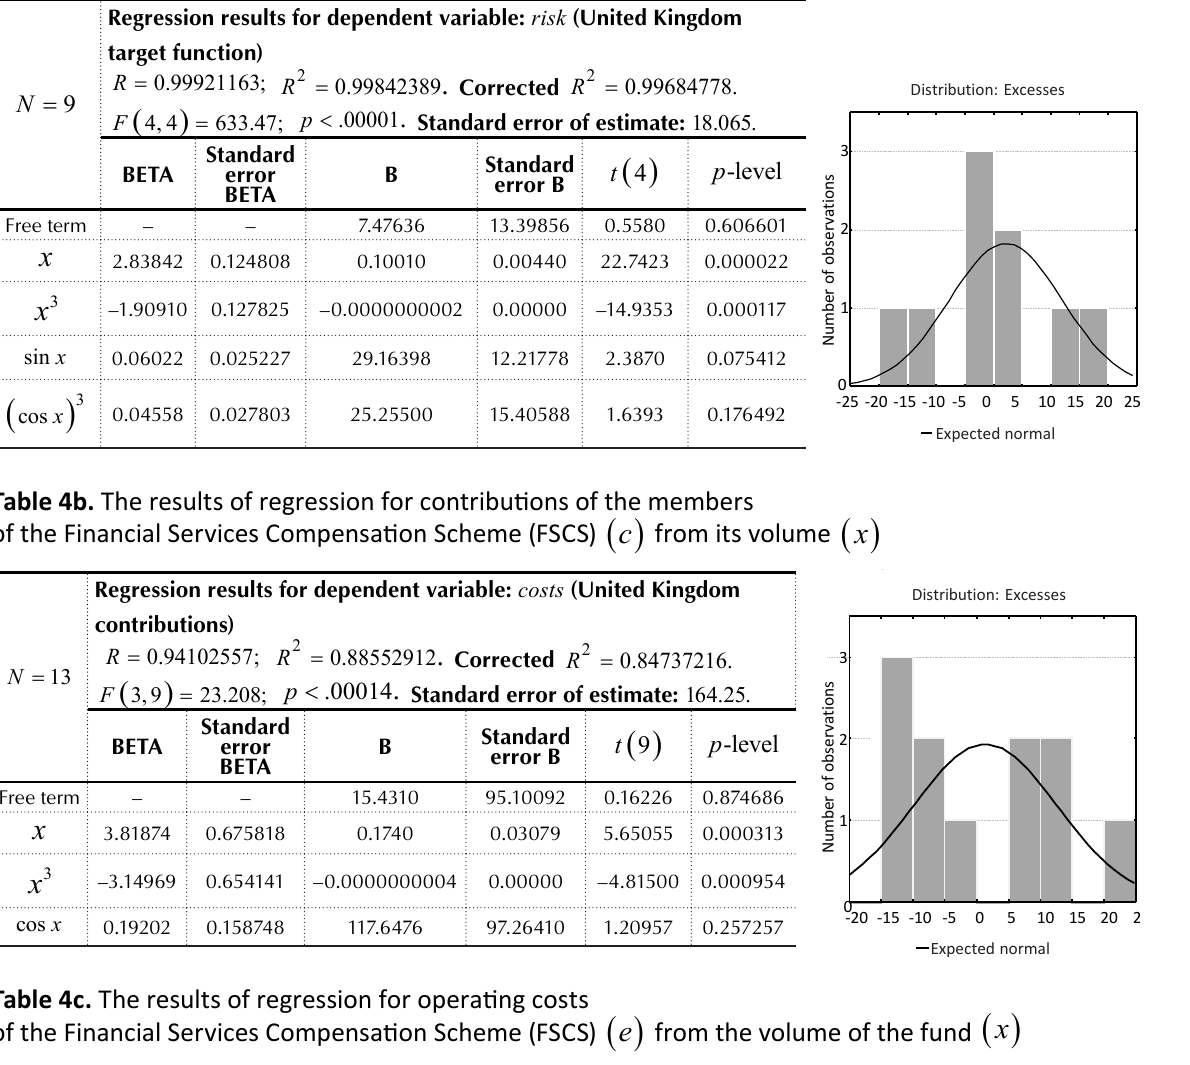
( ) y from its volume ( ) x